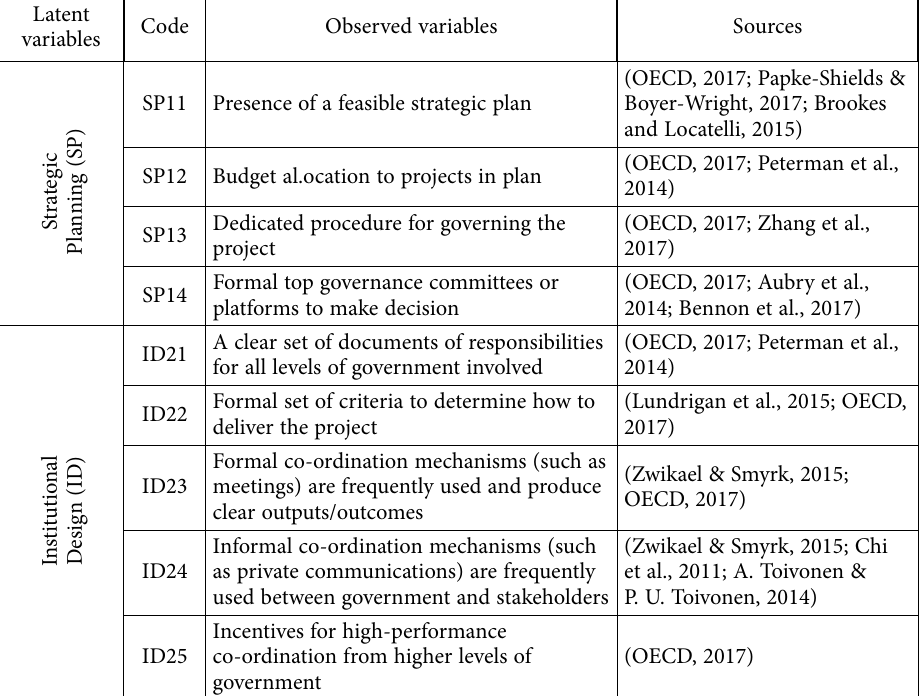
Table 1. Proposed framework of governmental